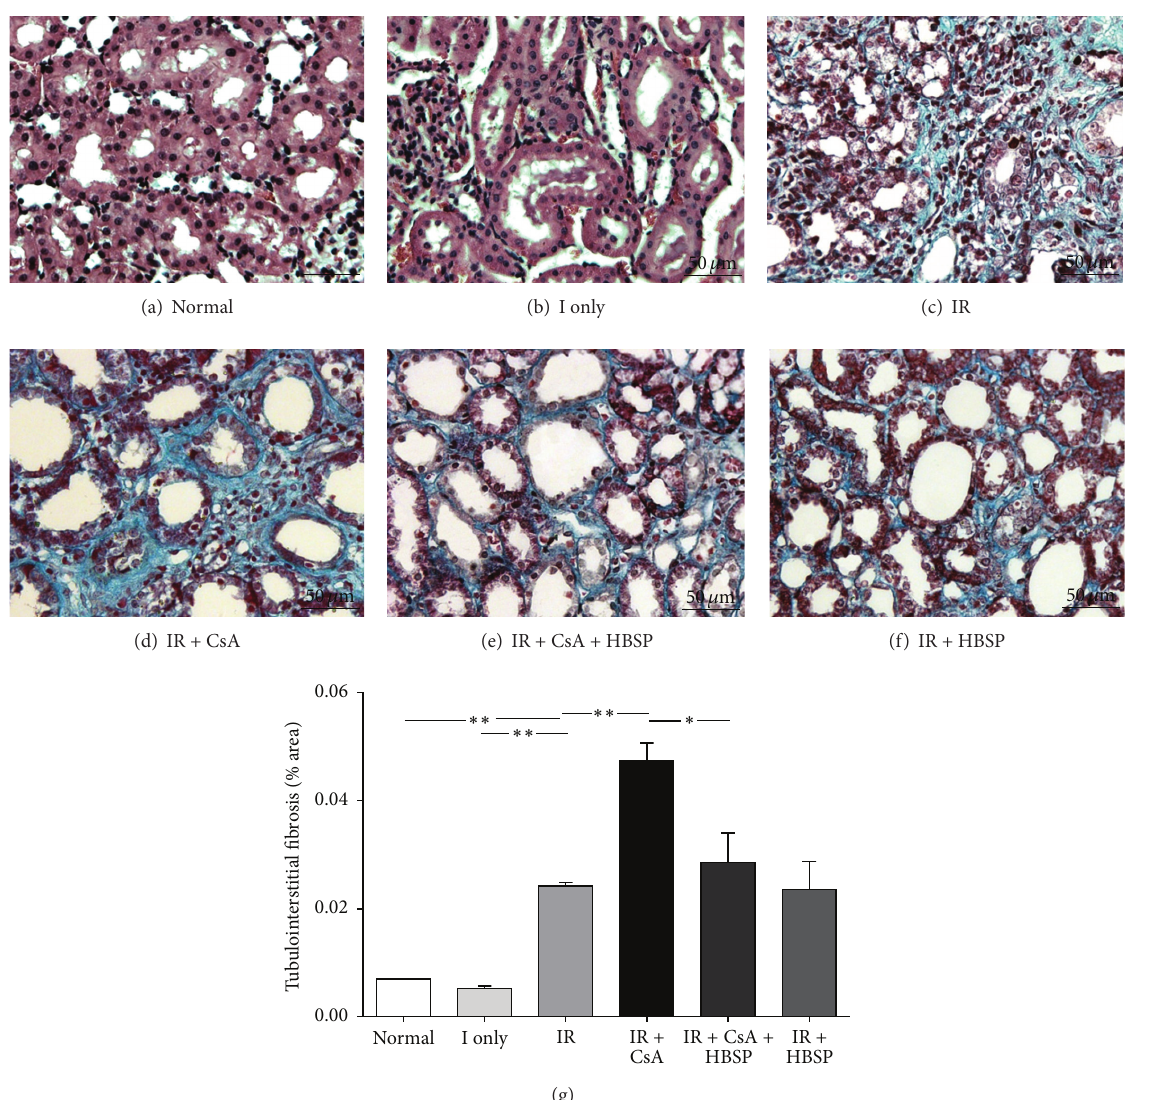
Figure 3: Tubulointerstitial fibrosis was detected by Masson’s Trichrome staining (a–f). IR did cause more collagen deposition compared with the normal or ischemia only group. The typical striped interstitial fibrosis and significantly increased extracellular collagen deposition in the cortex (400x) were shown in the IR + CsA group in comparison to the IR group, which was significantly lowered by HBSP (g). Data are expressed as the percentage of stained area per high power field of each group (mean ± SEM; 𝑛 = 6 ). ∗ 𝑃 < 0.05 ; ∗∗ 𝑃 < 0.01